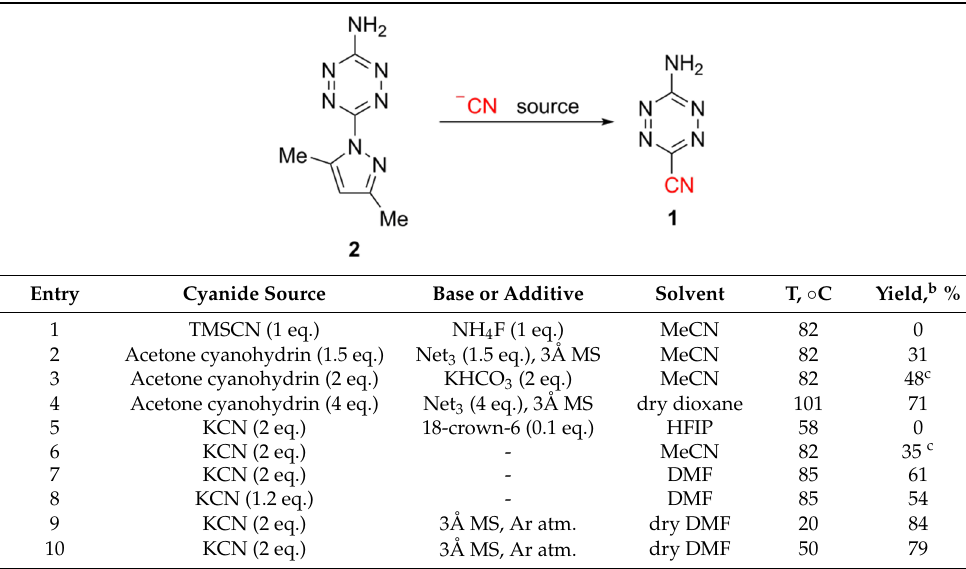
Table 1. Optimization of the reaction conditions for the synthesis of 1 a .